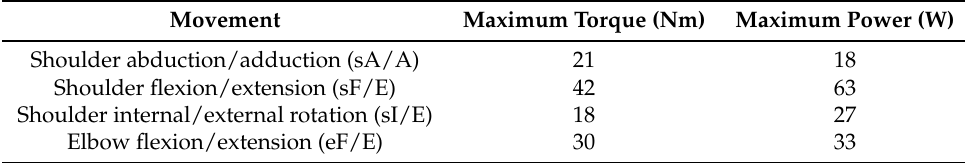
Table 1. Maximum torque and power, including the estimated weight of the exoskeleton.